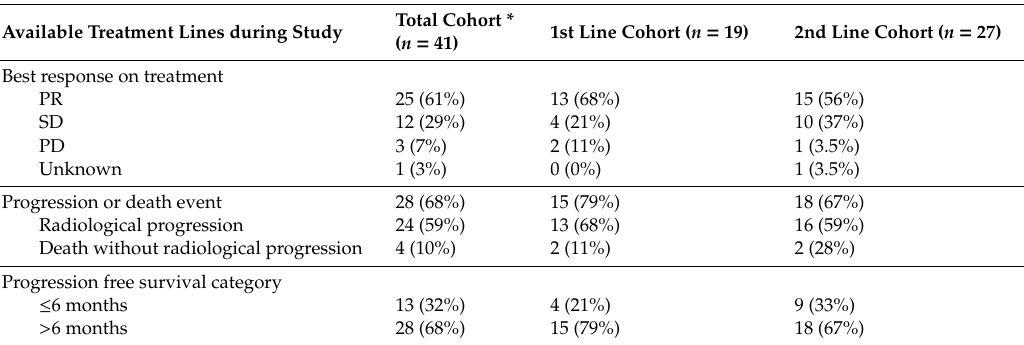
Table 2. Treatment lines during